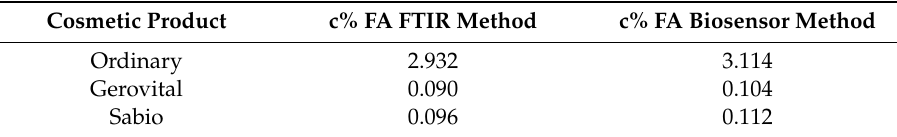
Table 6. The results of FA quantification in